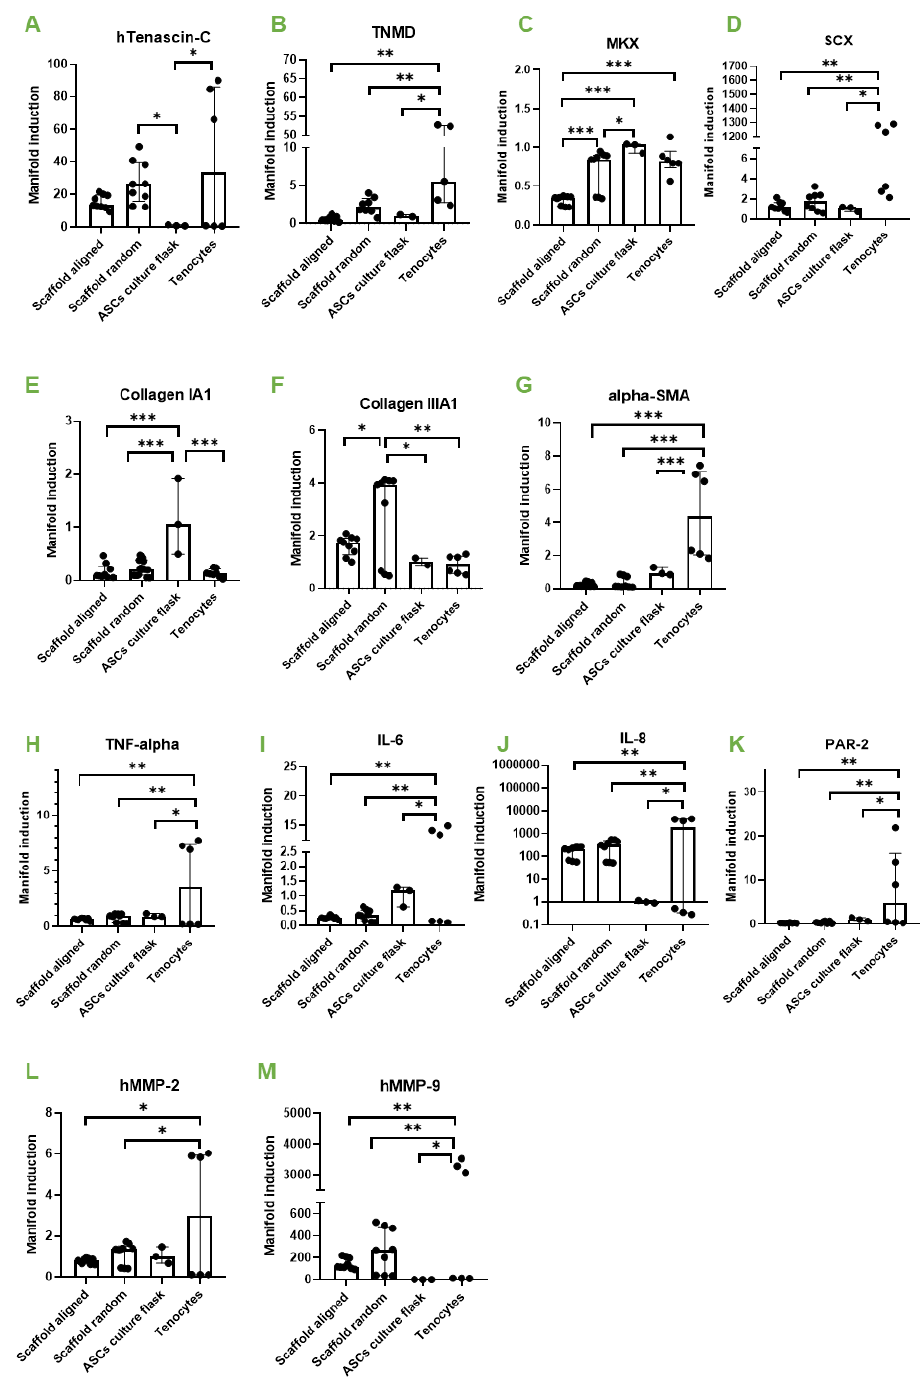
Figure 3. Aligned versus random. Gene expression of human ASCs (hASCs) on aligned PVDFhfp/PDMS, on random PVDFhfp/PDMS, cultivated in normal culture flasks (ASCs in culture flask) and human tenocytes (Tenocytes). Gene expression is shown as manifold induction compared to the ASCs in culture flask group (reference group set to 1). Median and interquartile range are shown. Key: * ( p < 0.05), ** ( p < 0.01) and *** ( p < 0.001) in a one-way ANOVA. ( A ) TNC , ( B ) TNMD , ( C ) MKX . ( D ) SCX . ( E ) Collagen 1A1 . ( F ) Collagen IIIA1 . ( G ) α -SMA . ( H ) TNF- α . ( I ) IL-6 . ( J ) IL-8 . ( K ) PAR-2 . ( L ) MMP-2 and ( M ) MMP-9